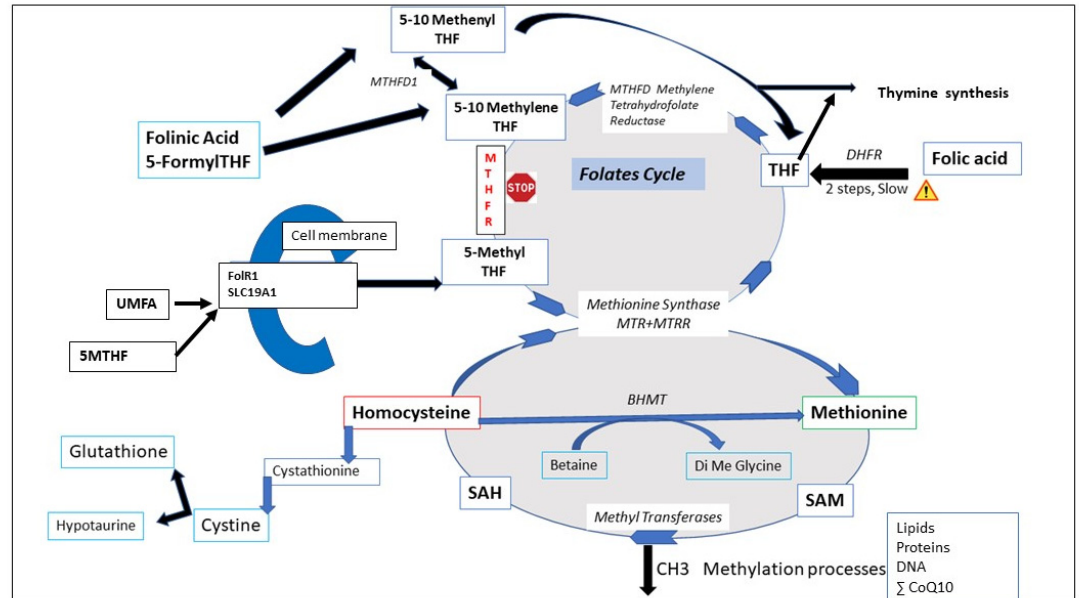
Figure 2. Interactions between the folates cycle and the one-carbon cycle. DHFR: dihydrofalate re- ductase, MTHFR: methylenetetrahydrofolate reductase. MTHFD1: methylenetetrahydrofolate